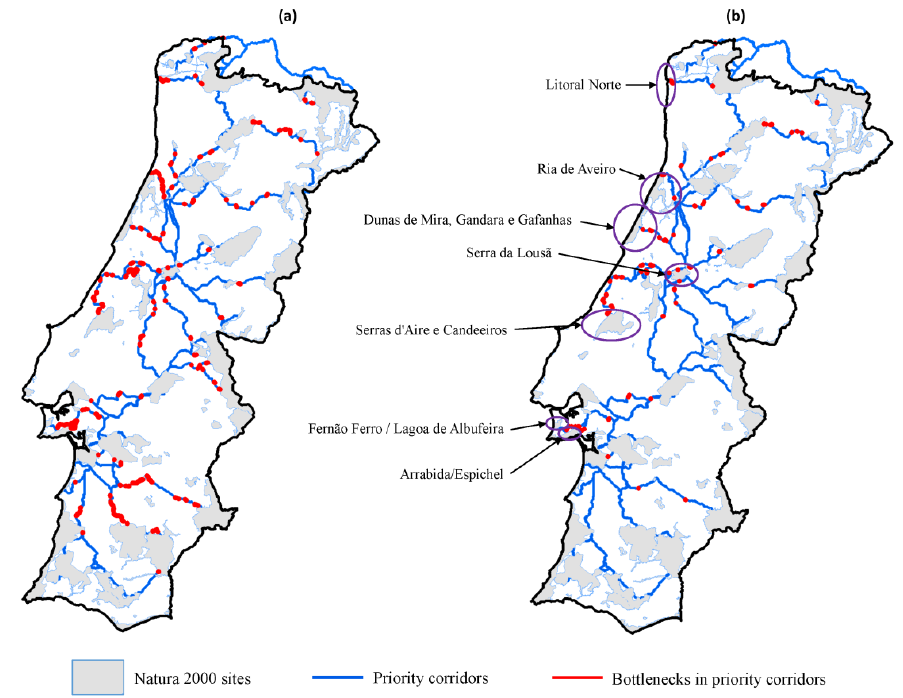
Figure 4. Bottlenecks inside priority corridors ( a ) and bottlenecks covered by purely coniferous forest, and hence more sensitive to the impacts of the pine wood nematode (PWN), in the priority corridors ( b ). The map in ( b ) specifies the name and location of some Natura 2000 sites at risk of increased isolation by PWN impacts. These sites are namely connected to other sites through linkages with bottlenecks in which purely coniferous forest exclusively ensures the remaining corridor